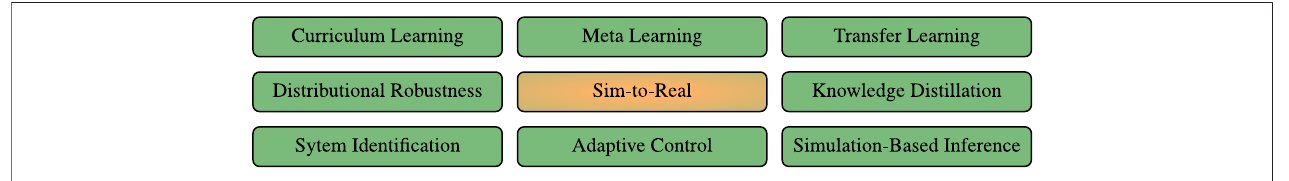
FIGURE 2 | Topological overview of the sim-to-real research and a selection of related fi elds.